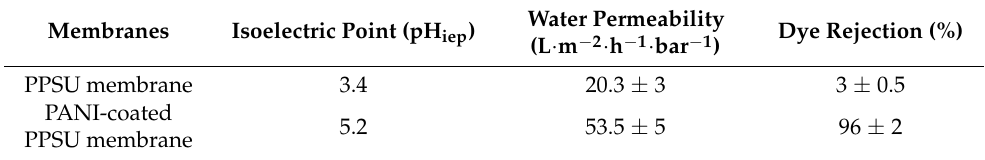
Table 1. Properties of the prepared membranes in this